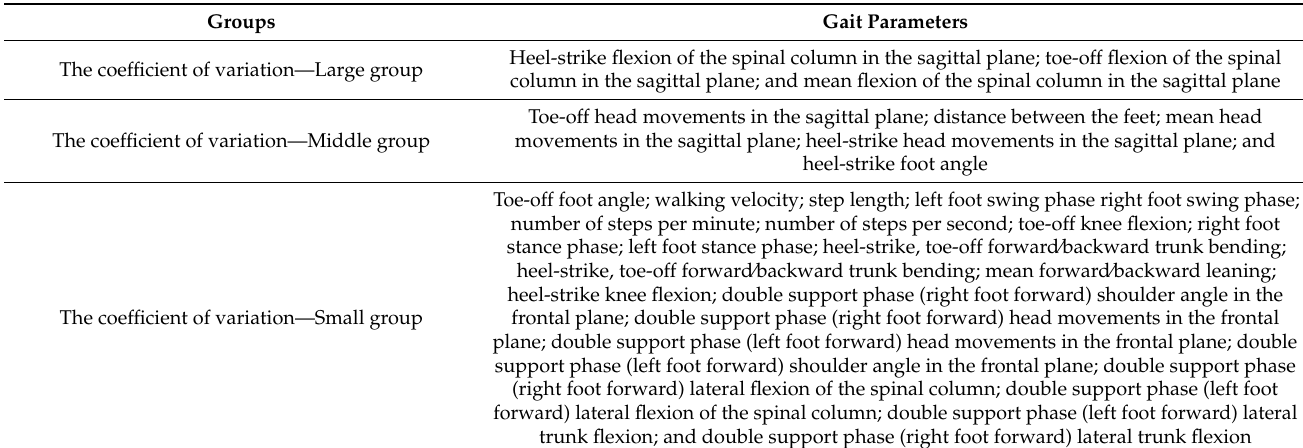
Table 6. The results of K-means clustering analysis of the CVs of gait parameters.